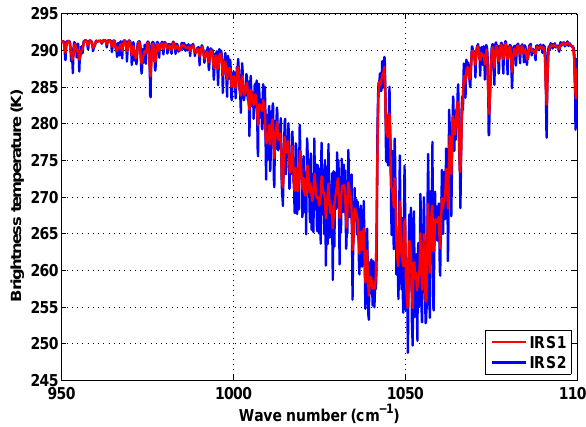
Figure 13. Impact of spectral resolution on the ozone lines in the 950–1100cm − 1 spectral range used for the ozone retrieval. Average over the whole tropical TIGR situations.